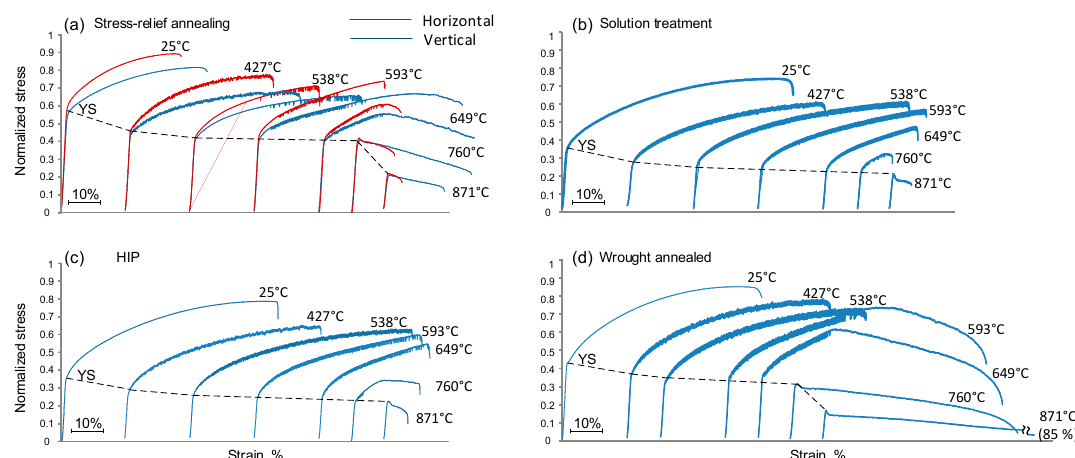
Figure 5. Stress–strain diagrams of the ( a ) SR-, ( b ) ST-, and ( c ) HIP-treated specimens and ( d ) wrought annealed alloy in the 25–871 °C temperature range.